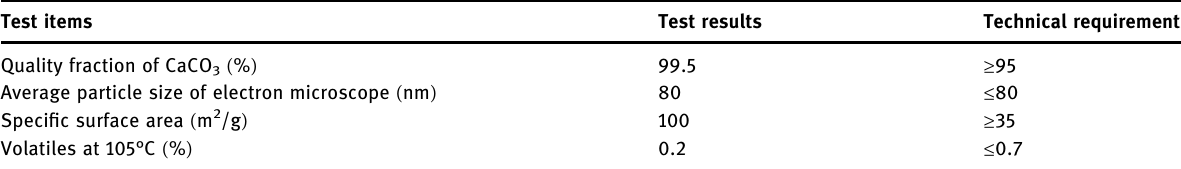
Table 2: Technical indicators of nano - CaCO 3 Test items